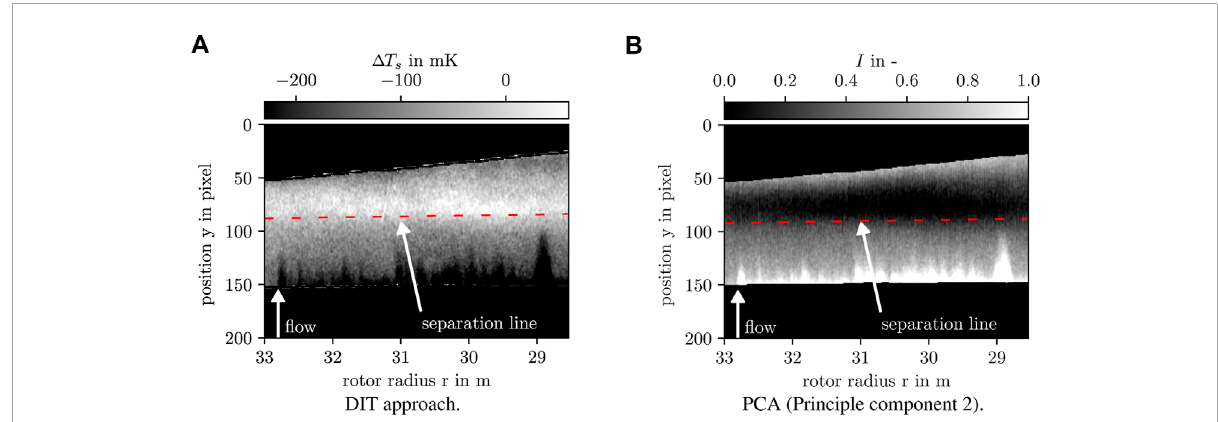
FIGURE 12 Application of the DIT approach and PCA on a repeat measurement during a cloud-free summer day. The selected exemplary differential thermogram enables a detection of the separation line by means of a maximum of the temporal temperature gradient. The PCA provides a high image contrast between the attached and the separated flow region. Finally, the reproducibility of the results of the first measurement is